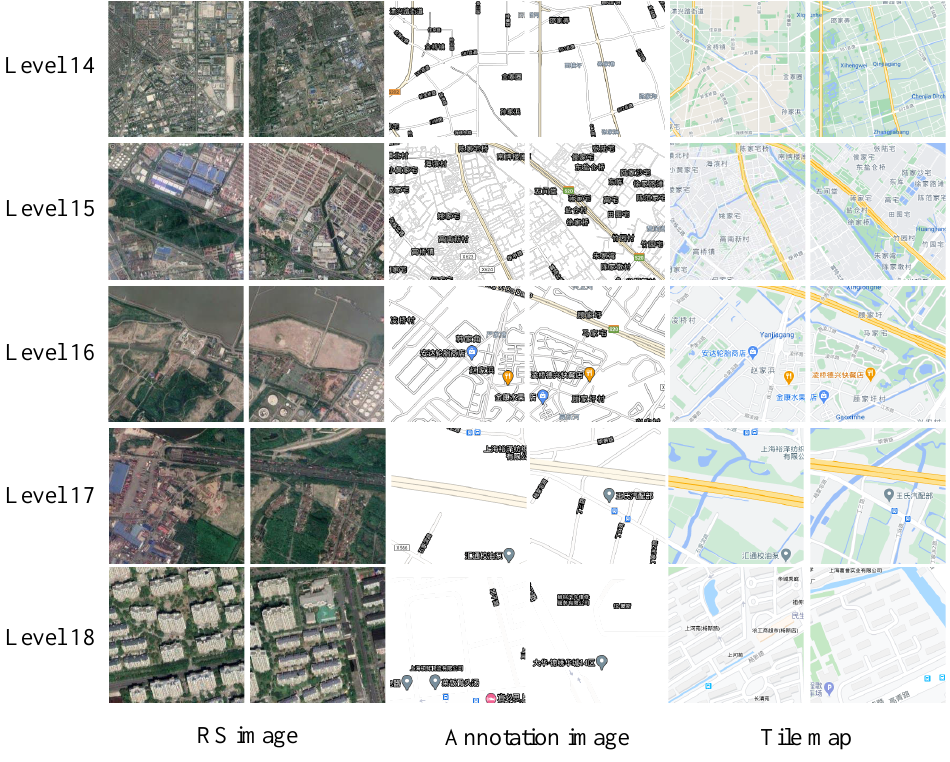
Figure 3. Examples from the self-annotated RS-image-to-map dataset at different levels, namely from the 14 to 18